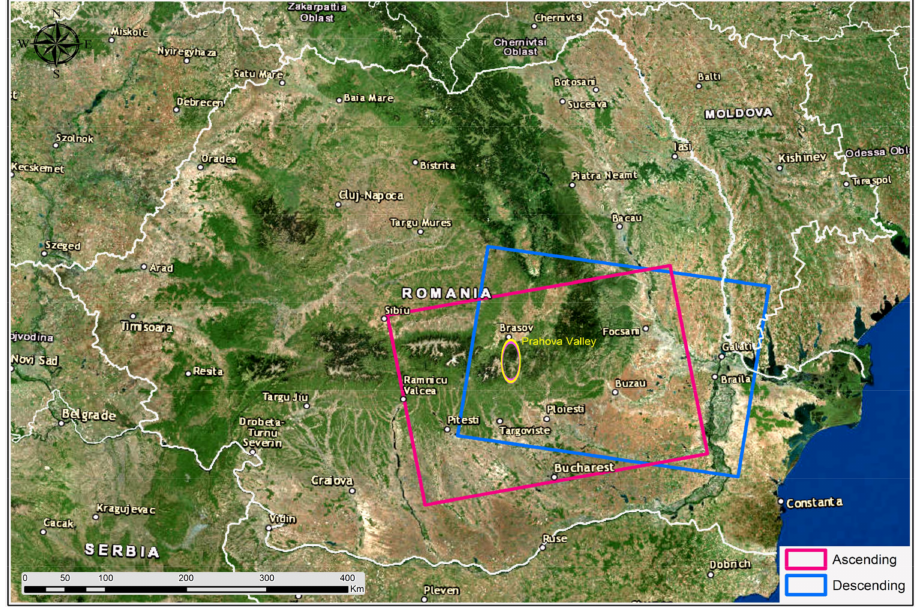
Figure 3. The extent of the areas including Prahova Valley that are covered by the acquisition orbit of the Sentinel-1A and Sentinel-1B satellites. Map created in Esri. ArcGIS ® and ArcMap™ 10.4.